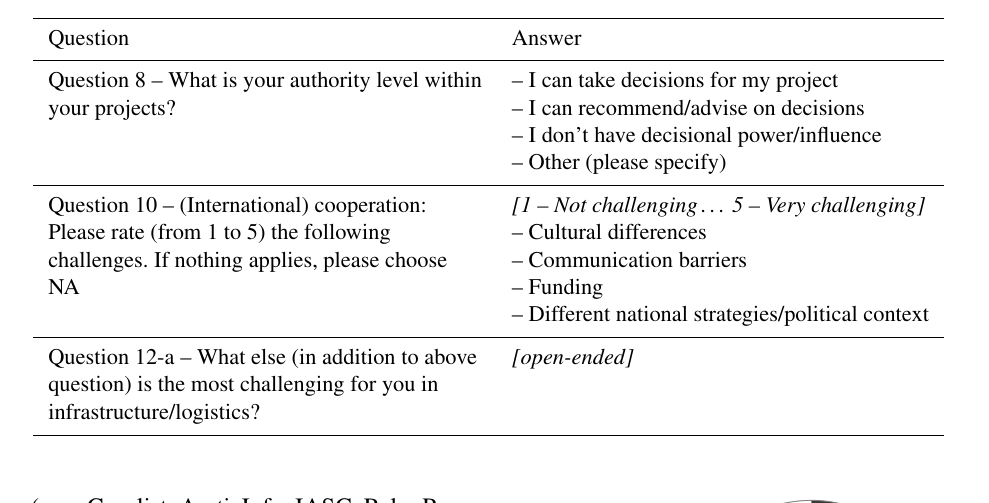
Table 1. Examples of questions in the developed survey.